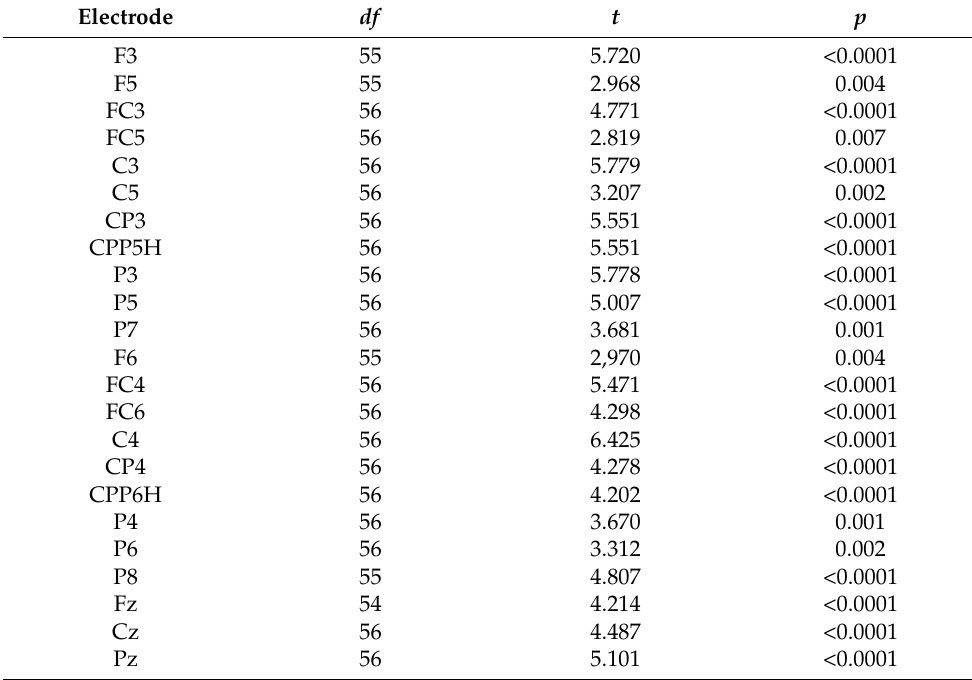
Table A1. Results of post-hoc t -tests comparing congruency levels for time window 300–400 ms.